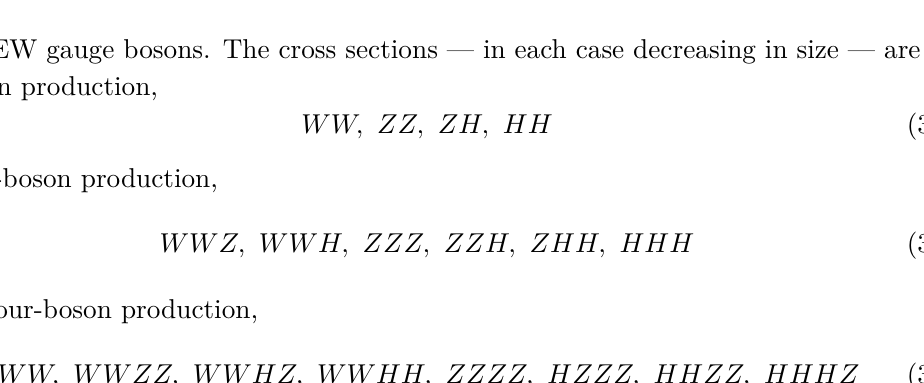
Figure 6 . Similar to figure 4, the cross sections of four-boson production at a µ + µ − collider as a √ function of the c.m. energy s , for SM κ µ = 1